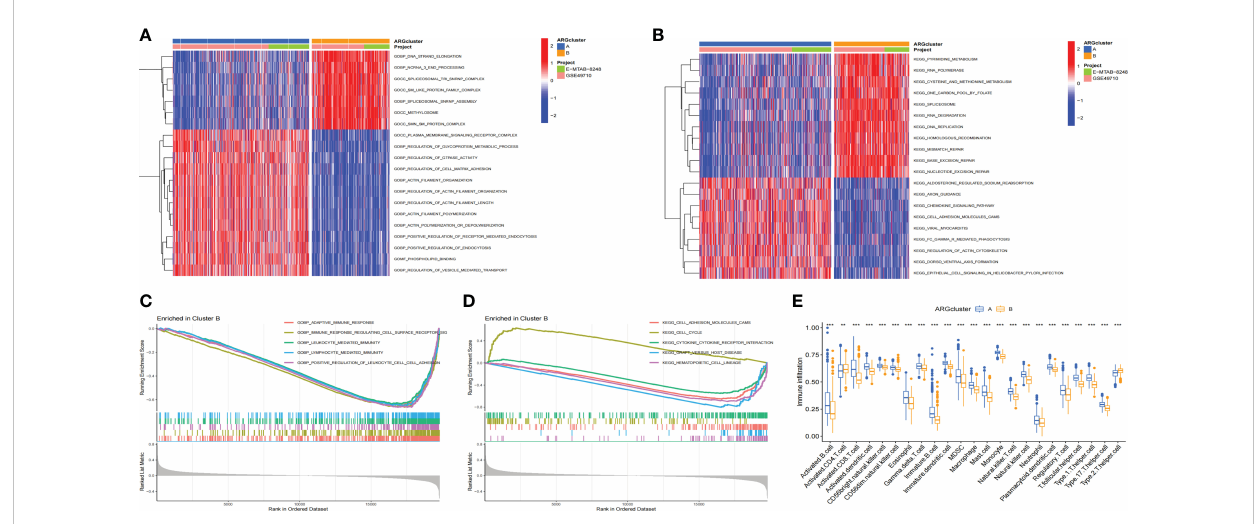
FIGURE 3 GSVA and GSEA analyses and immune cell in fi ltration in different ARClusters. (A, B) . Enrichment pathways between ARCluster B and ARCluster A through GSVA enrichment analysis. (C, D) . Enrichment pathways between ARCluster B and ARCluster A through GSEA enrichment analysis. (E) . Difference of the in fi ltration levels of immune cells between ARCluster A and ARCluster B through SsGSEA. **, p < 0.01; ***, p <